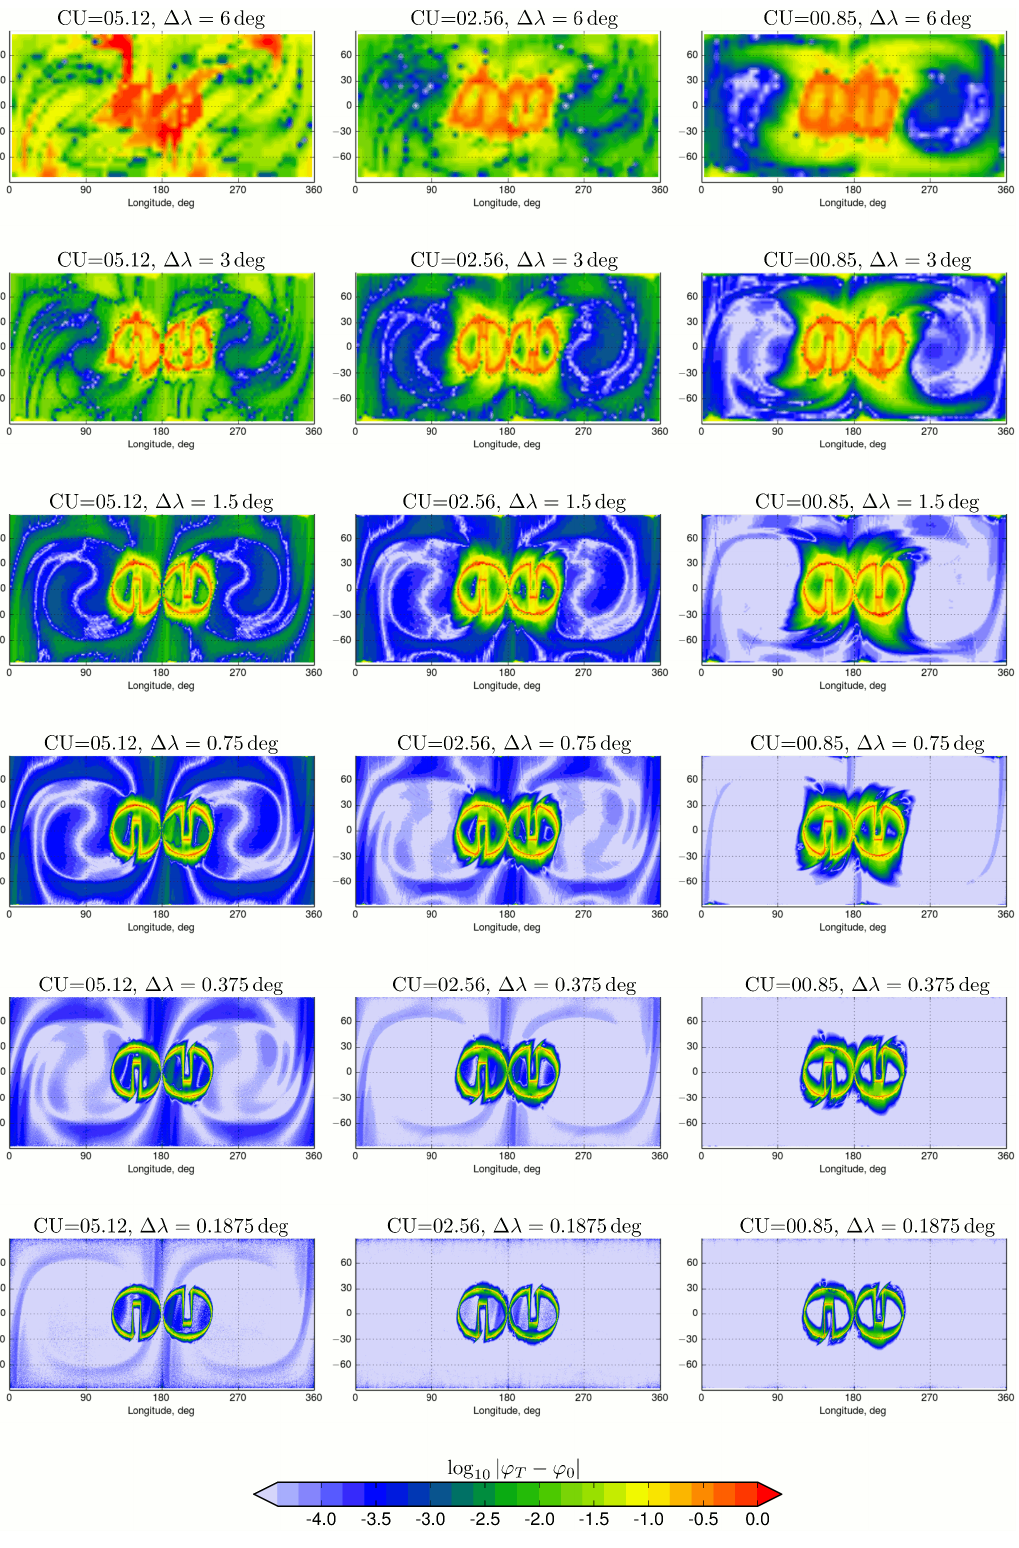
Figure 11. The error fields for the final shapes of Fig. 10 as compared with the slotted cylinder initial shape in Fig. 8. Without